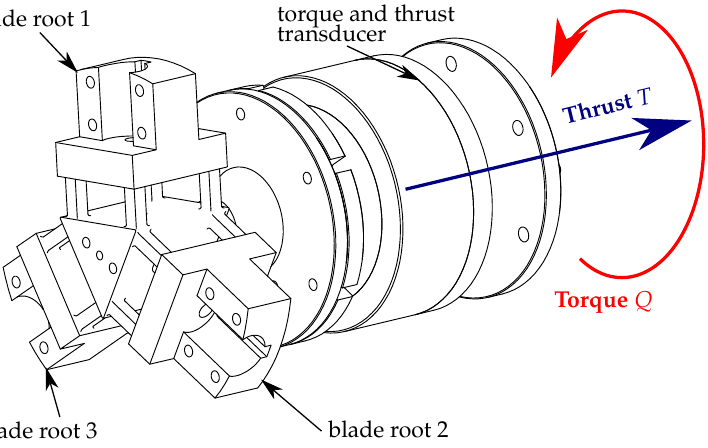
Figure 2. The torque and thrust transducer.